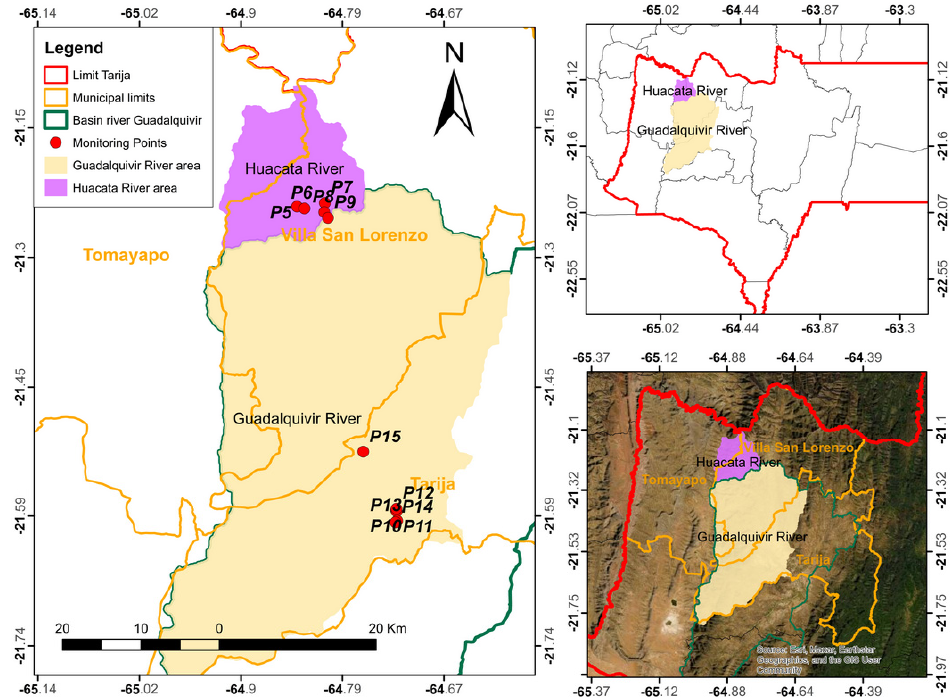
Figure 8. Map of the monitored points in the Guadalquivir Basin .